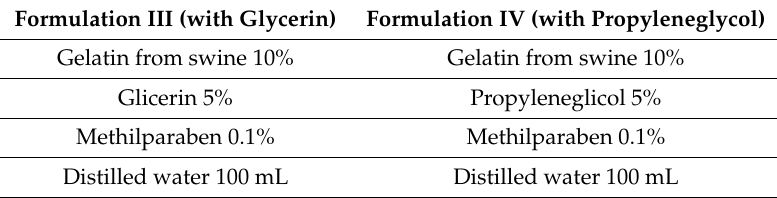
Table 3. Formulation of biotherapeutic with collagen from